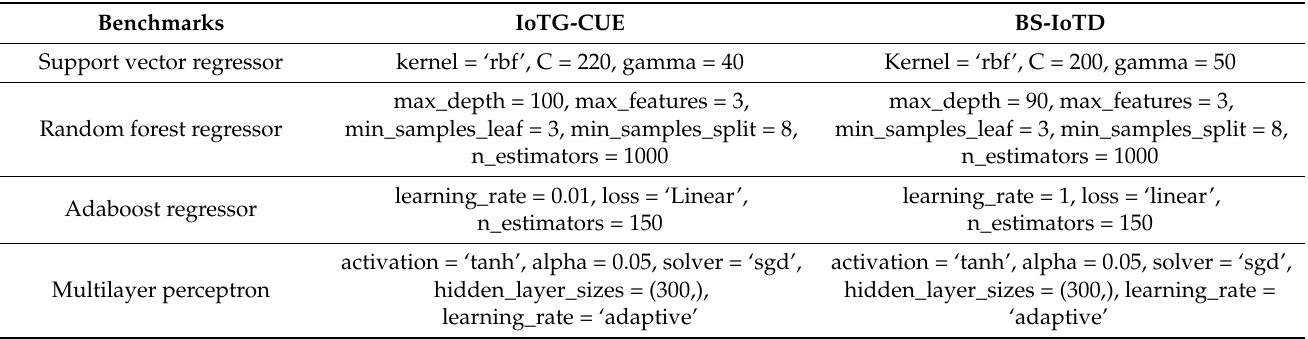
Table 4. Optimal parameters generated for the benchmarks used in the uplink model evaluation.